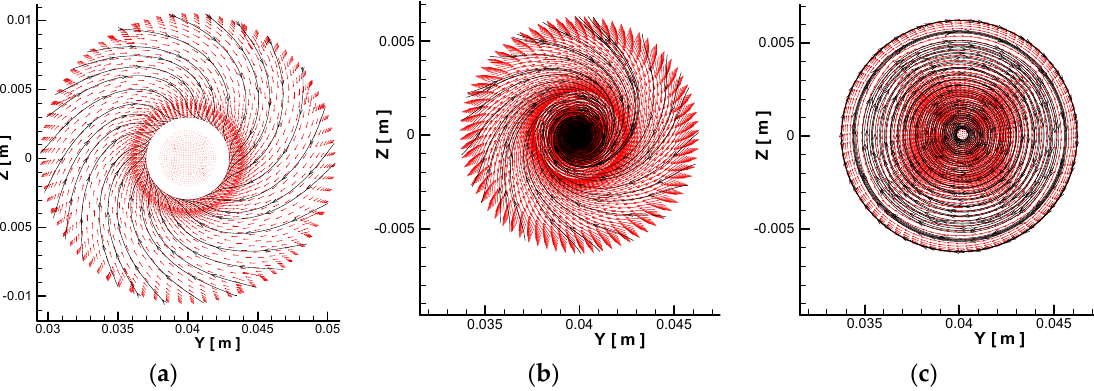
Figure 2. Evolution of the flow field structure at different cross-sections in the test system: ( a ) Section 1; ( b ) Section 2 (nozzle throat); ( c ) Section 3.